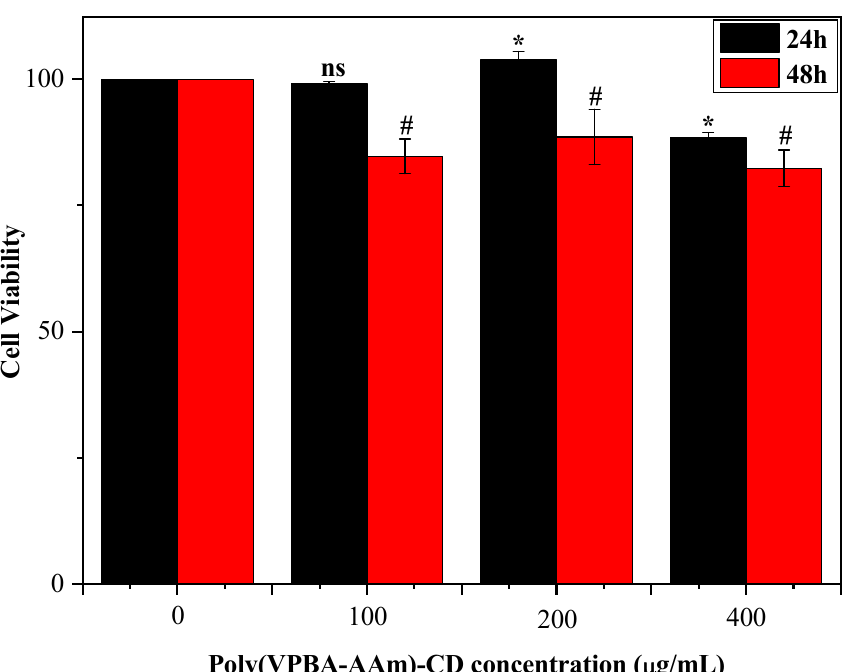
Figure 8. Viability of HL-7702 cells incubated with different concentrations of poly(VPBA-AAm)-CD for 24 h and 48 h by MTT assay. * p < 0.05 compared with the control group at 24 h, # p < 0.05 compared with the control group at 48 h, “ns” means no significance.